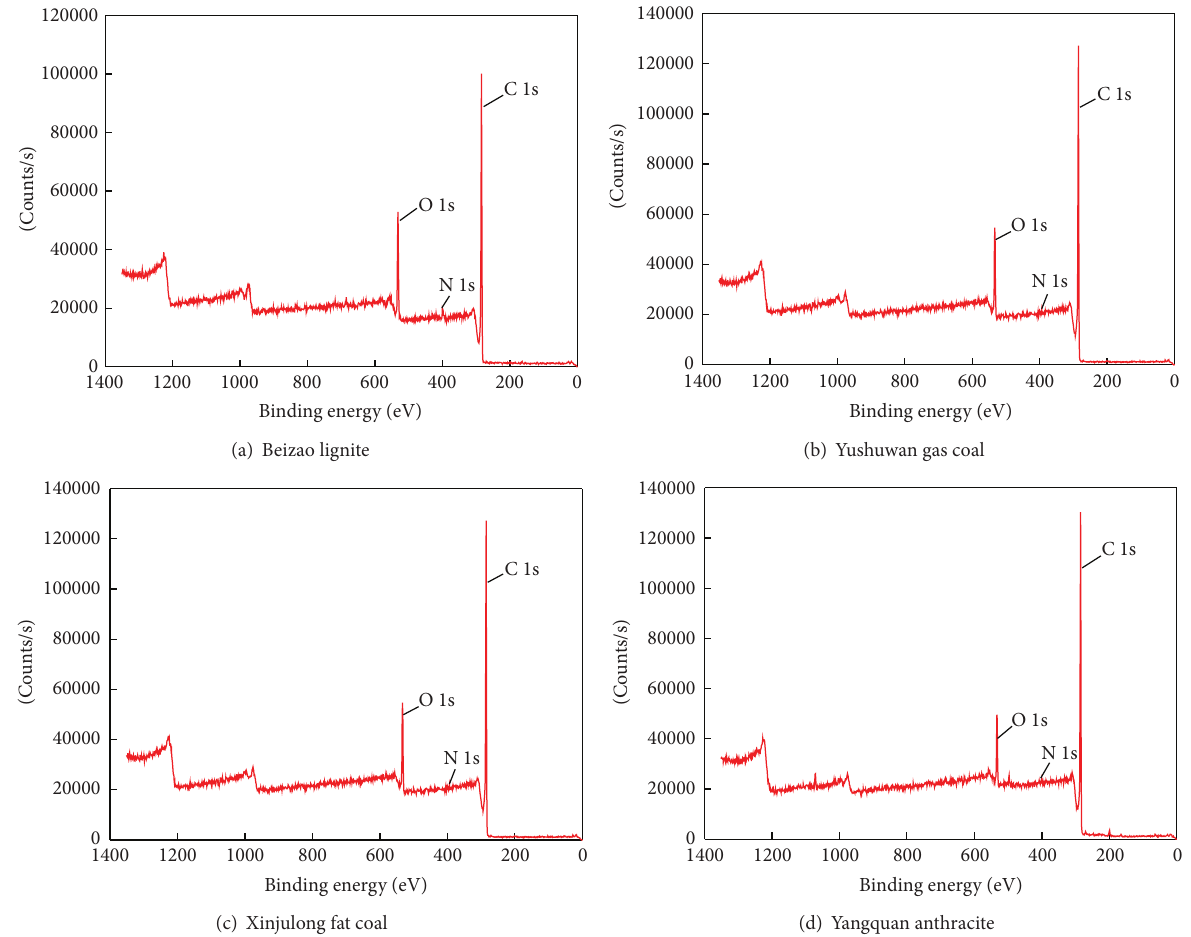
Figure 1: Chart of XPS full spectrum scan of coal samples with different metamorphic